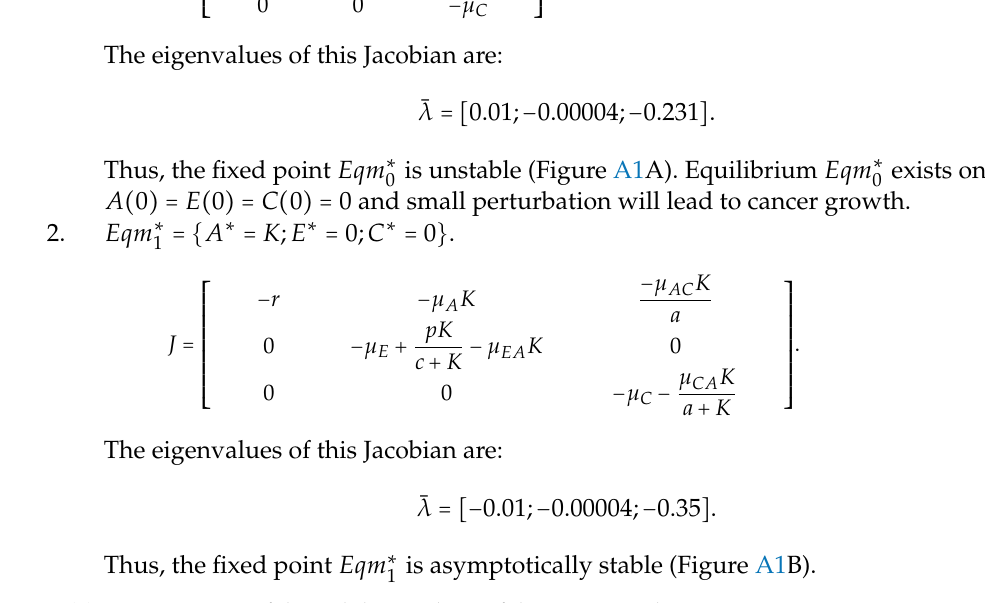
Table A1. Summary of the stability analysis of the system without treatment. Fixed